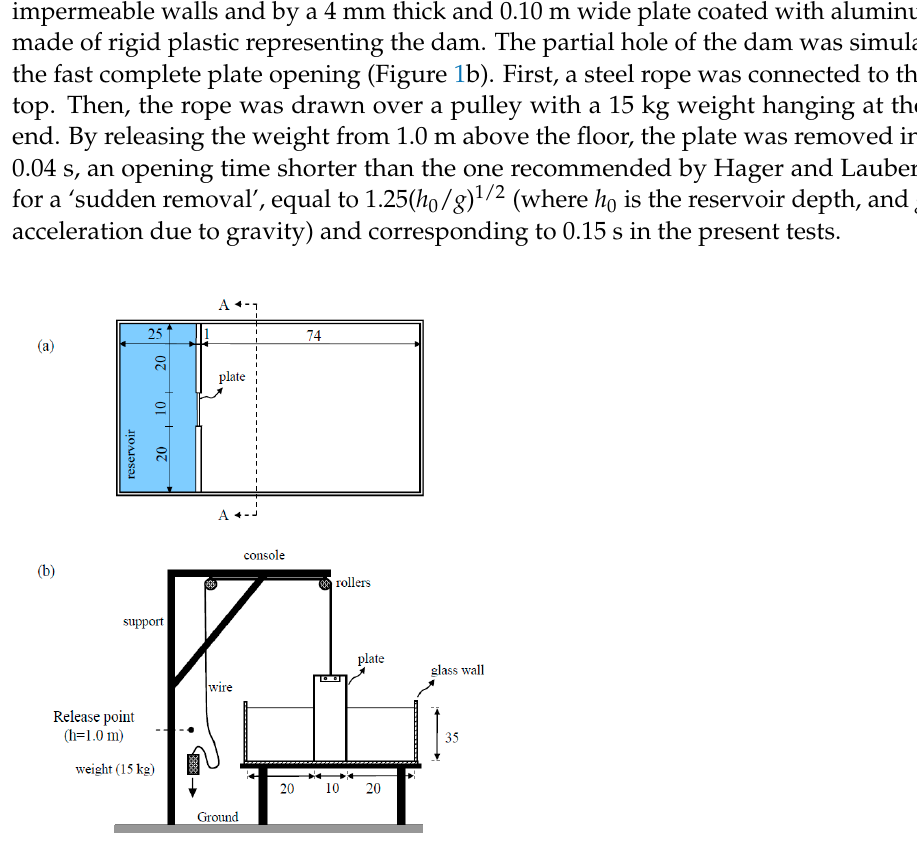
Figure 1. Schematic view of experimental setup and plate removal mechanism: ( a ) Plan and ( b ) A-A cross-section. Lengths are in